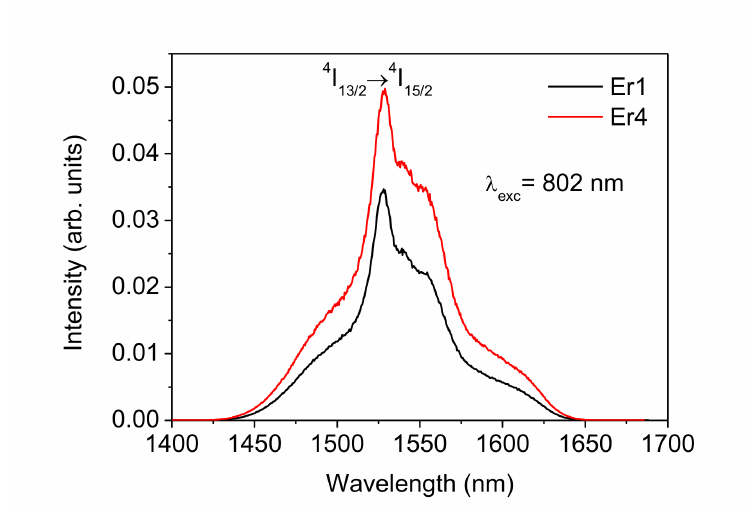
Figure 4. Emission spectra of the 4 I 13/2 → 4 I 15/2 transition for Er-doped aluminosilicate glasses with 1 wt% and 4 wt% under excitation at 802 nm.